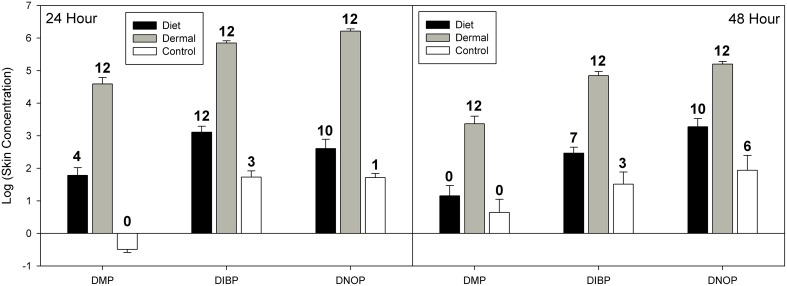
Phthalate concentrations in western fence lizard skin samples at 24 and 48 hour time points.Data for 24 hours and 48 hours are presented as log10 means (ng/g ± SE). Phthalate congeners are: di-methyl phthalate (DMP), di-iso-butyl phthalate (DIBP), and di-n-octyl phthalate (DNOP). Linear mixed effects models suggest significant effects of exposure route (χ2 = 122.5, df = 2, p<0.001) and phthalate congener (χ2 = 99.0, df = 2, p<0.001), and a significant effect of time (χ2 = 9.13, df = 2, p = 0.002). See text for complete statistical information. Numbers above error bars indicate the number of detections out of 12 samples. At 48 hours, 2 oral treatment samples were lost during extraction and, therefore, detections listed are out of 10 samples.